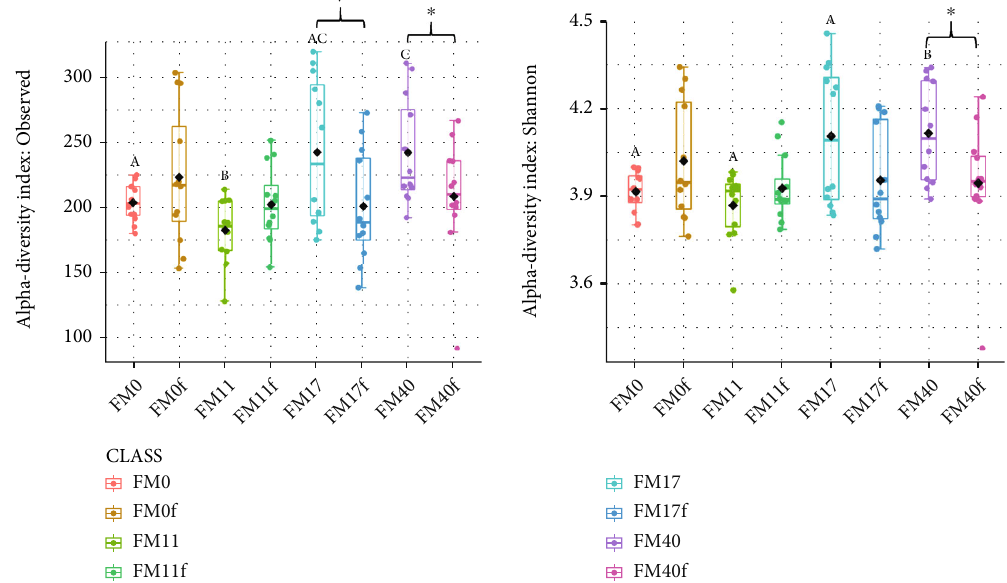
Figure 16: The alpha diversity indices for digesta-associated microbiota in the intestine of Atlantic salmon fed with diets containing diverse levels of fi shmeal and their respective counterparts with functional ingredients. (a) Observed species and (b) Shannon index. Di ff erent letters indicate signi fi cant di ff erences among the dietary groups without supplementation. ∗ indicates signi fi cant di ff erence between the dietary groups without and with supplementation. Table 12: Beta diversity of gut microbiota in fi sh fed with diets containing diverse levels of fi shmeal and their respective counterparts with functional ingredients. Bray – Curtis dissimilarity matric¤ Pairwise comparisons